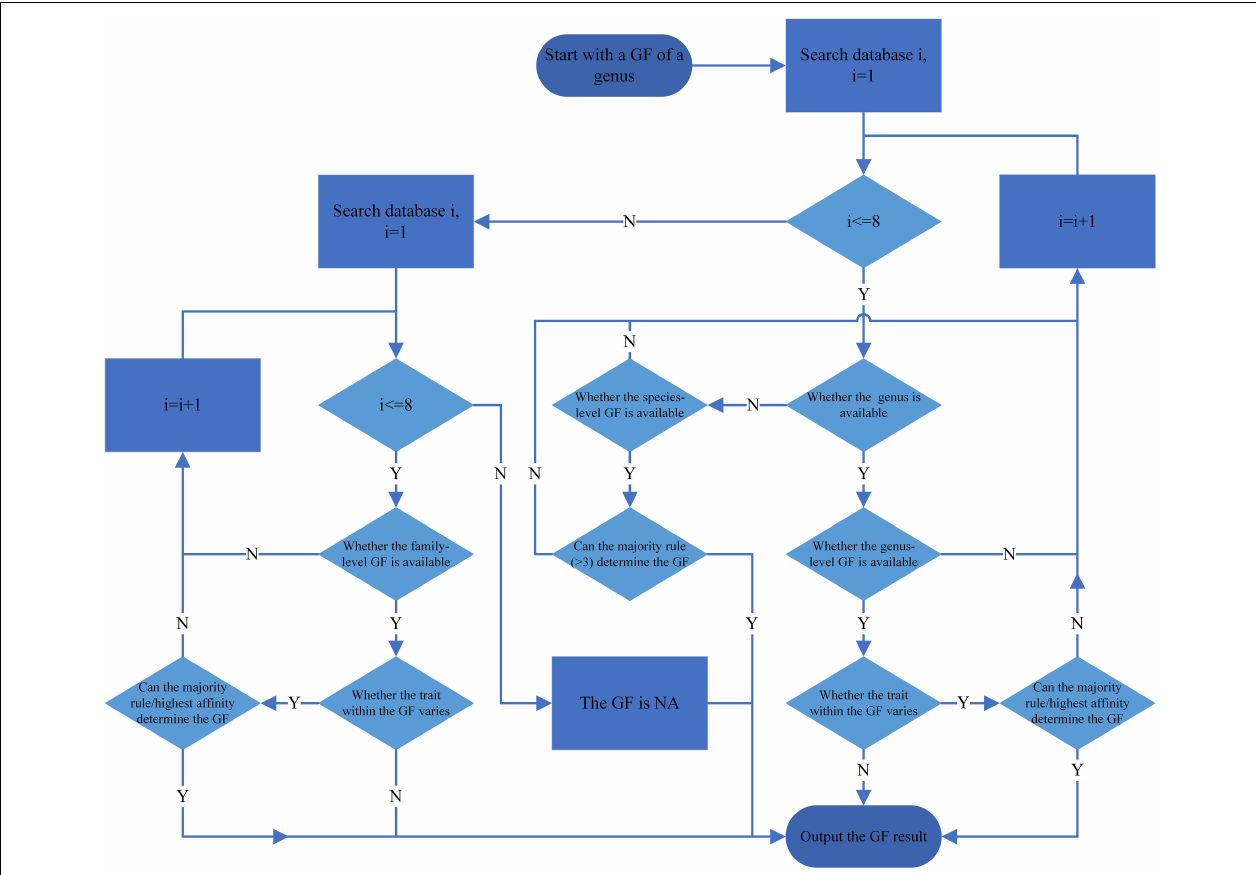
FIGURE 1 | Flowchart for determining genus-level grouping features (GF) from the databases. The oval represents a start or end point, the rectangle represents a process, and the diamond represents a decision. According to the databases searching sequence, the databases are considered as databases one to nine,